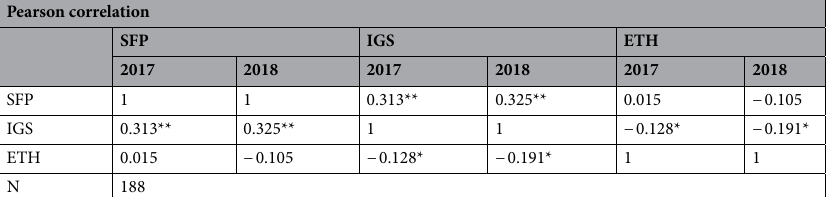
Pearson correlation